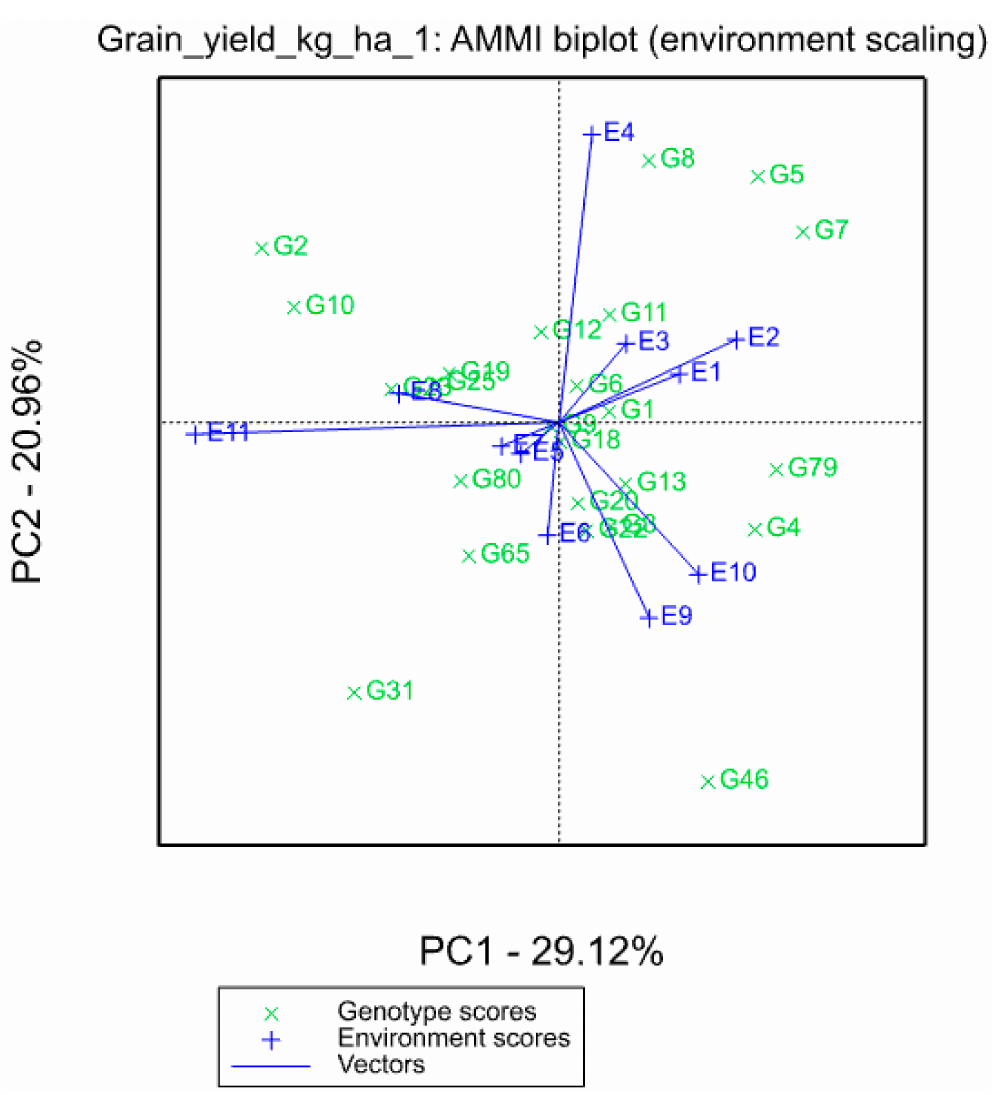
Figure 2. Biplot of the additive main effects and multiplicative interaction (AMMI) showing the relationship among 11 testing environments (E1–E11). (Codes of genotypes in Table 1 and environments in Table